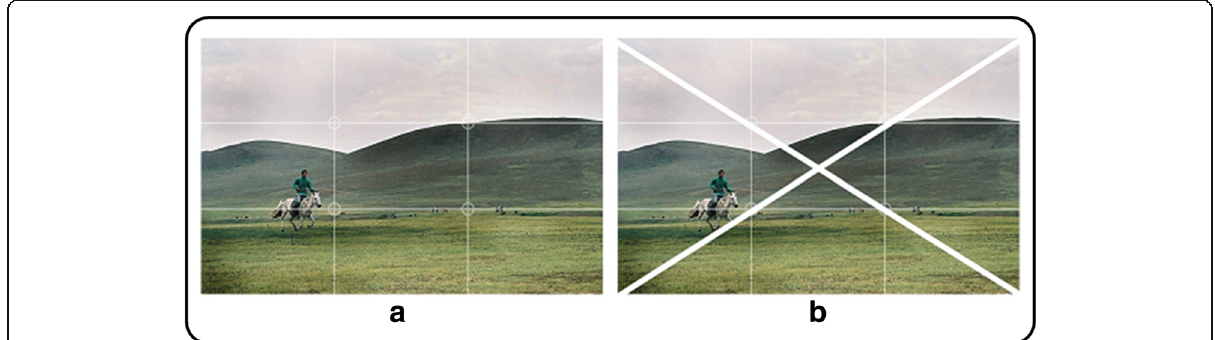
Fig. 1 Image a http://mikemellizaphotography.blogspot.com/ is showing the photographic rule of thirds, while image b is showing its division into four adapted triangular areas